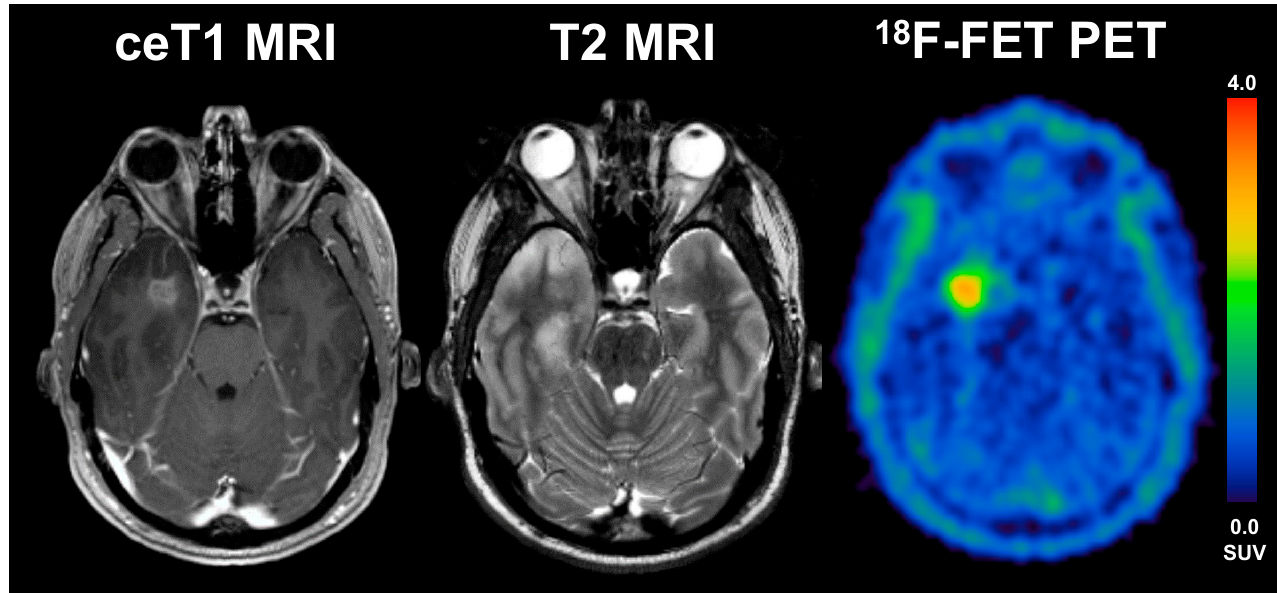
Figure 3. A 33-year old male patient with glioblastoma (WHO grade IV, IDH wildtype, MGMT methylated) and an overall survival of 47 months (LTS). The diameter of CE on T1 MRI was 17 mm, volume of CE was 28 mL, the BTV in FET-PET was 16 mL, the TTP min was 17.5 min and TBR max 4.1. The patient underwent radio-chemotherapy.